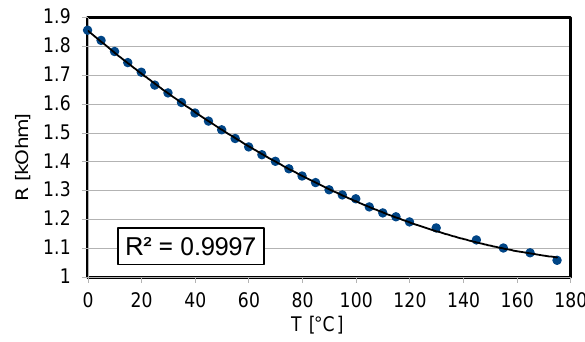
Fig. 5. Impact of sensor temperature on the value of its resistance (spark plug No. 1)